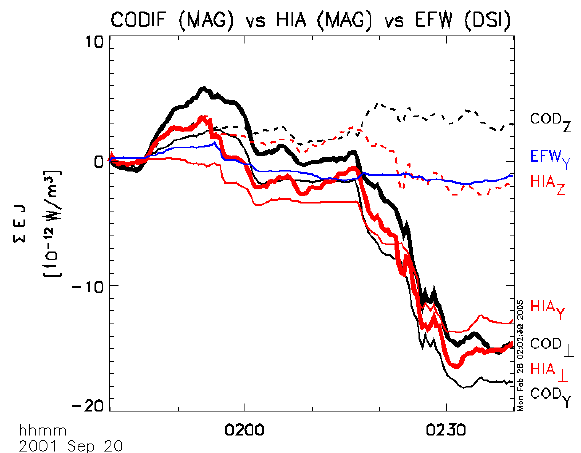
Fig. 10. Cumulative sums of E · J , with E estimated from CODIF (black), HIA (red), and EFW (blue) data. In each case the electric field is averaged over the satellites where the respective instrument is operational. For CODIF and HIA the thick solid lines show the total, while the thin solid and dashed lines indicate the contributions from the Y MAG and Z MAG directions. For EFW only the contri- bution from the Y DSI direction is